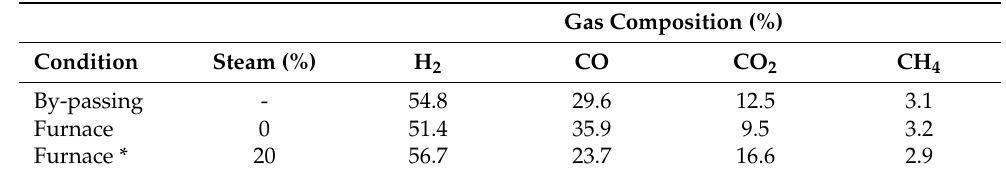
Table 7. Gas concentration variation considering the gas flow through the furnace at 600 ◦ C with and without steam. Measurements had a standard deviation inferior to